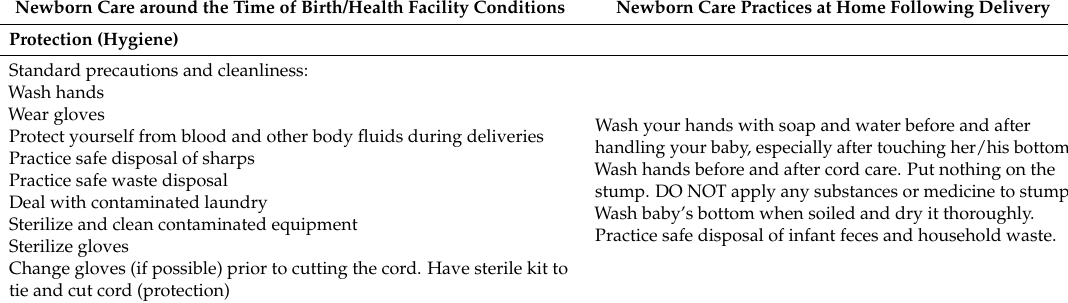
Table A1. Analytic framework of newborn care